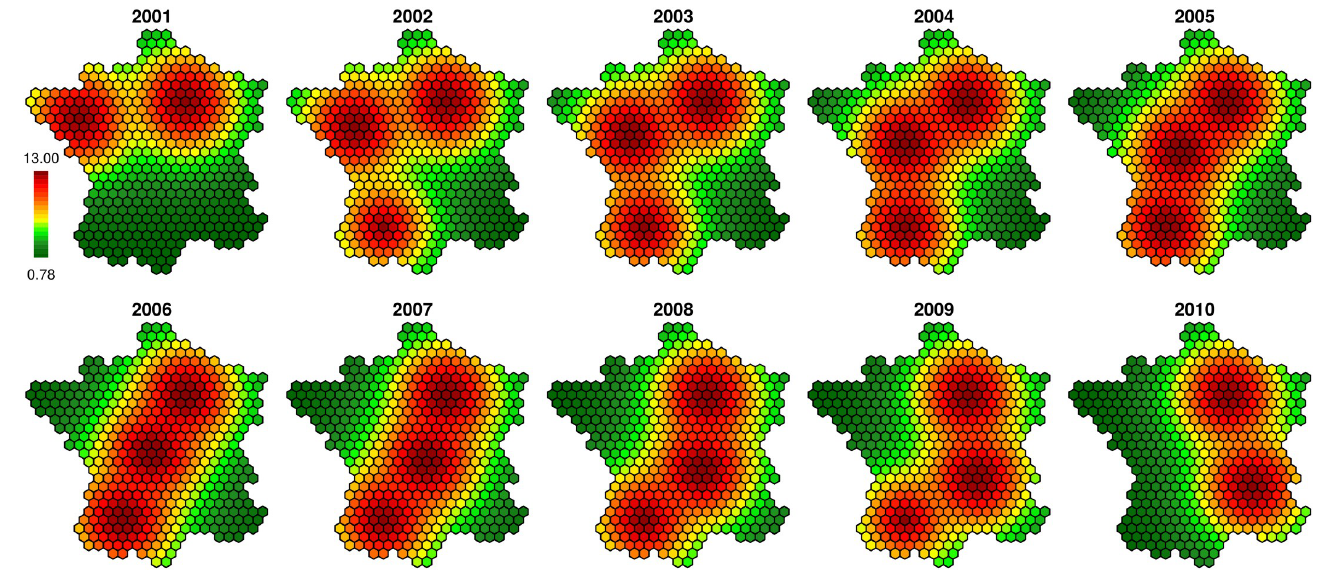
Fig 3. Risk map with the 3